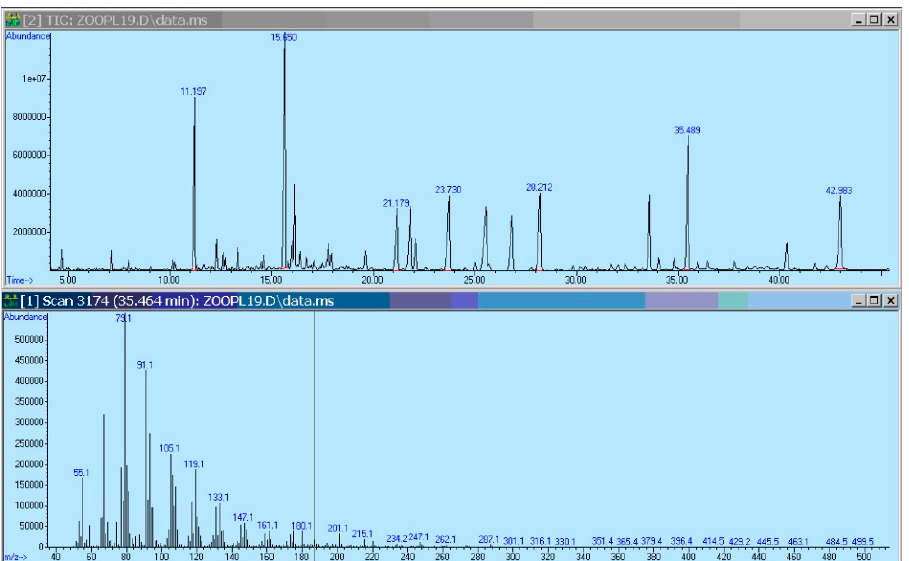
Figure 1. An example of an experimental chromomatogram. The upper panel is the chromatogram for fatty acids from total lipids of zooplankton from mesotrophic conditions. The lower panel is a mass-spectrum of the fatty acid peak located at 35.489 min.